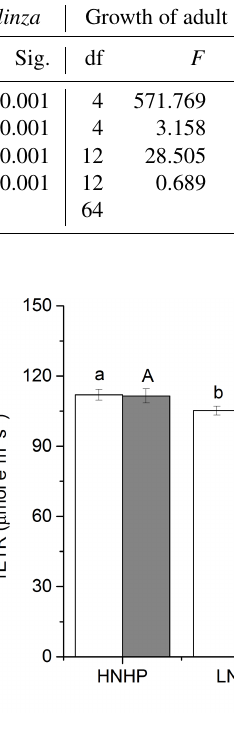
Figure 4. Relative electron transport rate (rETR) of adult U. linza grown under various conditions. LC, 400µatm; HC, 1000µatm; LN, 6.1µmolL − 1 ; LP, 0.2µmolL − 1 ; HN, 106.1µmol L − 1 ; HP, 10.2µmolL − 1 . The error bars indicate the standard deviations ( n = 3). Different letters above the error bars (lower case for LC and cap- ital for HC) represent significant differences ( P < 0.05) among nu- trient treatments while horizontal bars represent significant differ- ences ( P < 0.05) between LC and HC within a nutrient